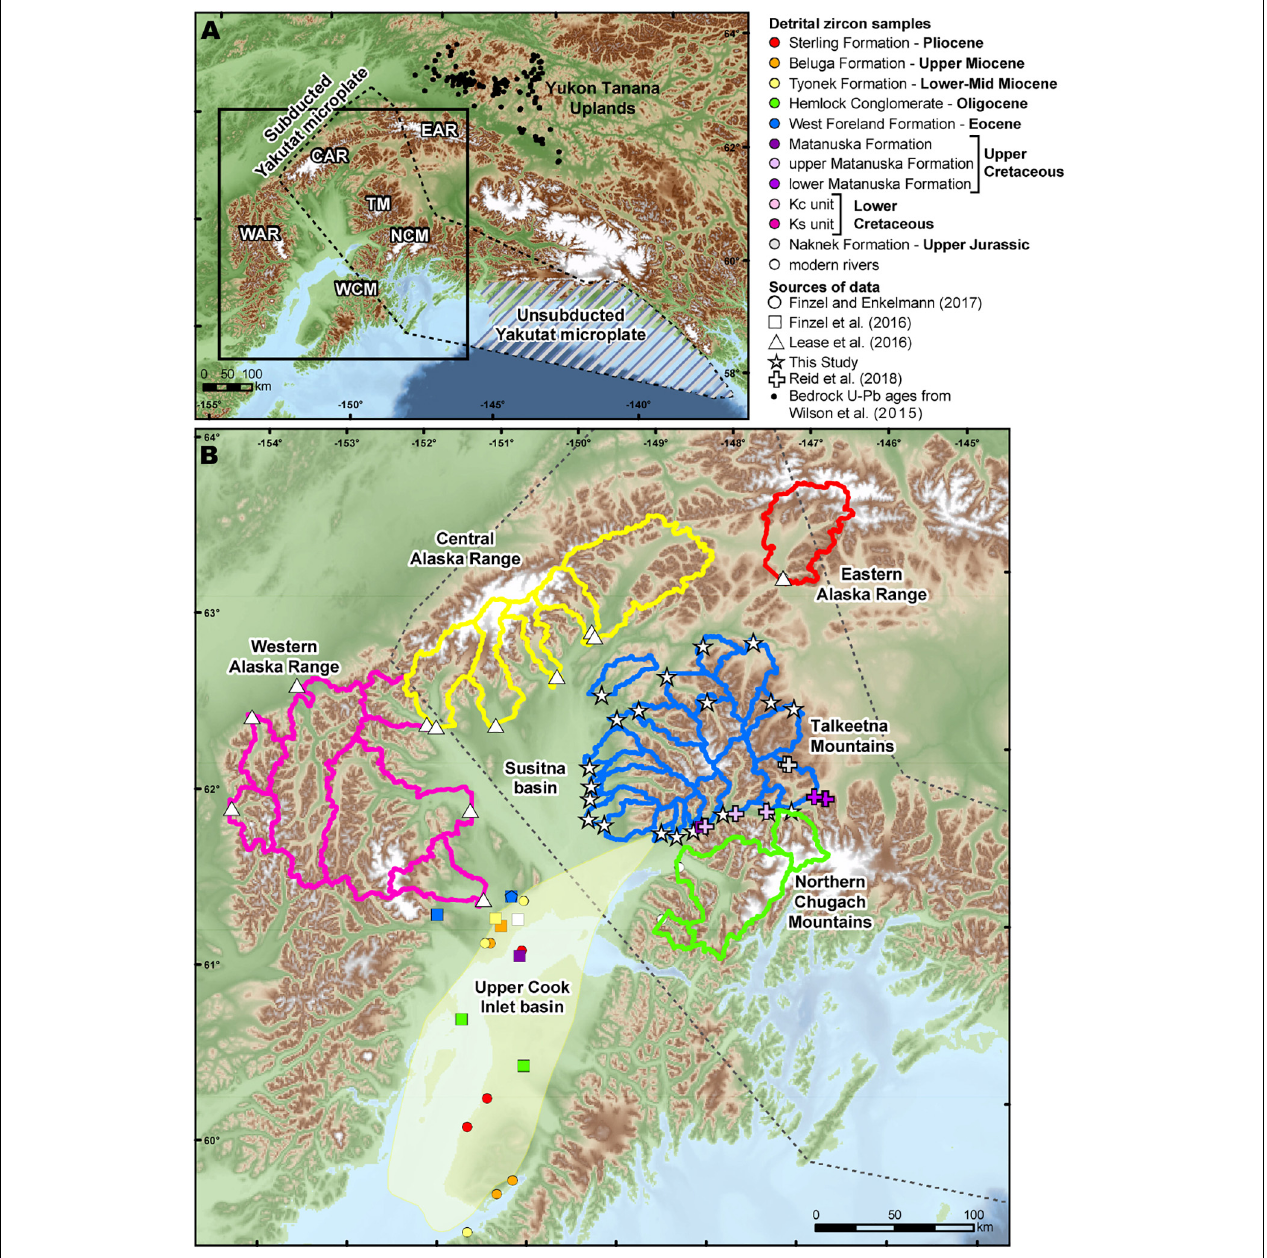
FIGURE 1 | (A) Location map of south-central Alaska showing extent of subducted and unsubducted Yakutat microplate, major mountain belts, the Yukon Tanana Uplands, and the study area (black box is area shown in (B) . WAR, western Alaska Range; CAR, central Alaska Range; EAR, eastern Alaska Range; TM, Talkeetna Mountains; NCM, northern Chugach Mountains; WCM, western Chugach Mountains. (B) Location map of the study area showing the watersheds for detrital zircon samples from modern rivers in the western Alaska Range (pink), central Alaska Range (yellow), eastern Alaska Range (red), Talkeetna Mountains (blue), and northern Chugach Mountains (green), locations of basin strata samples, and generalized outline of the modern-day Cook Inlet basin. Note that forearc strata are contained within the basin, whereas accretionary prism strata are found in the uplifted Chugach Mountains. The sample symbols denote both the source of the data (by shape) and the depositional age (by